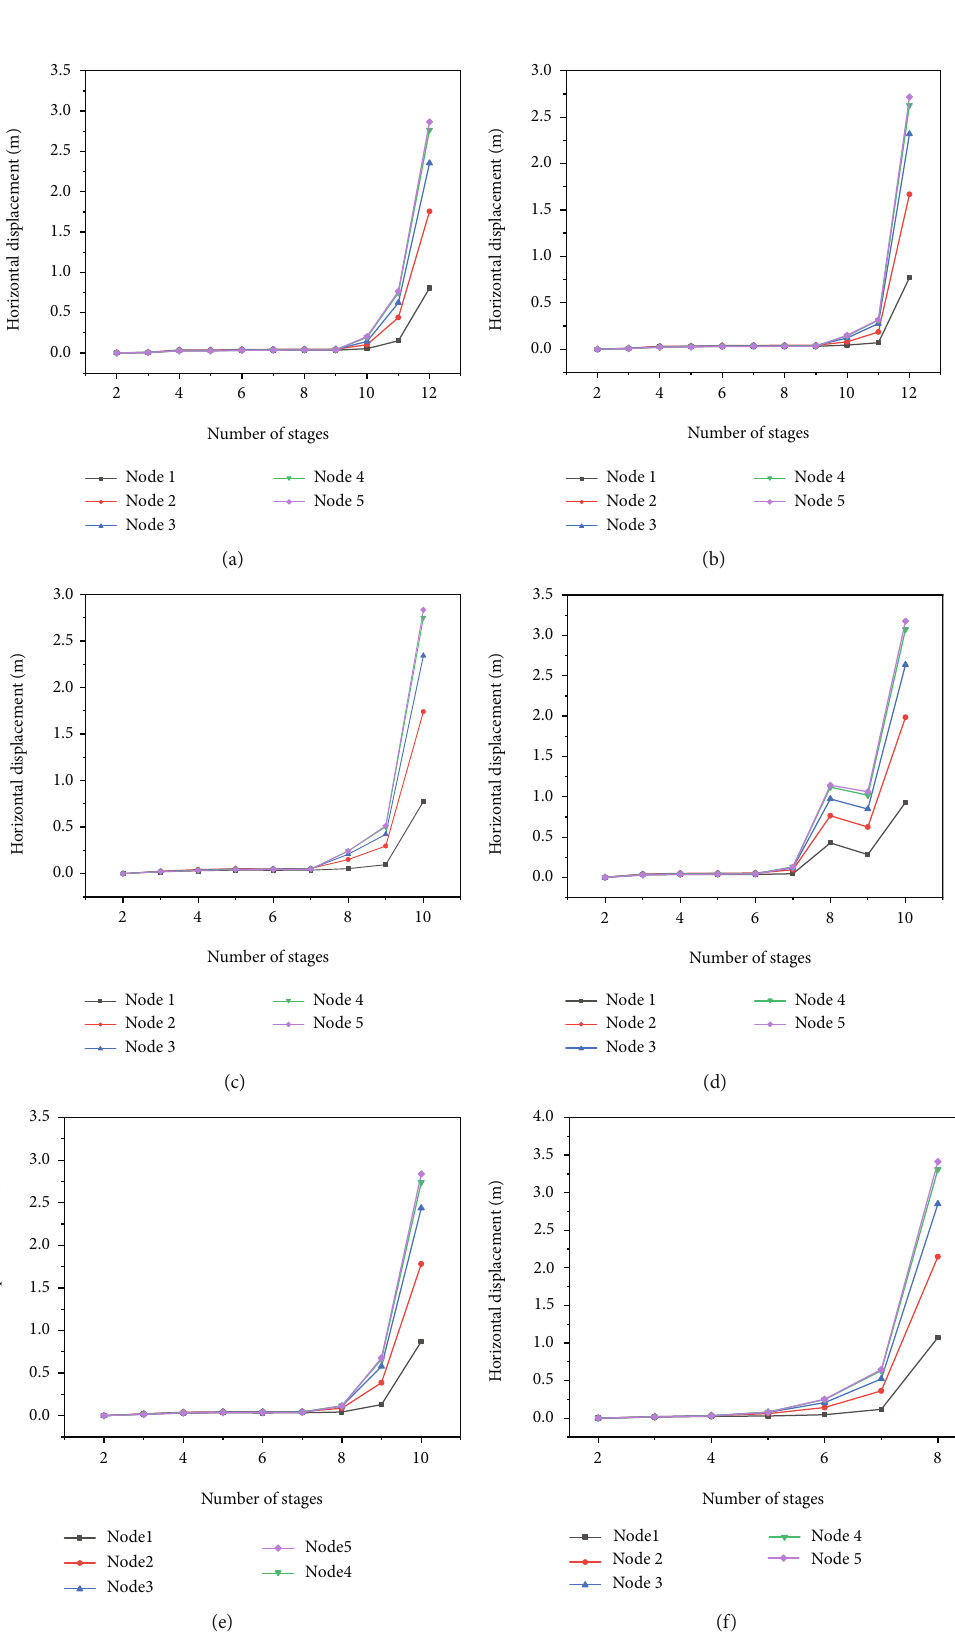
Figure 18: Horizontal displacement curve of each point under di ff erent times of the freeze-thaw cycle ((a – f) The times of the freeze-thaw cycle are 0, 20, 40, 60, 80, and 100,